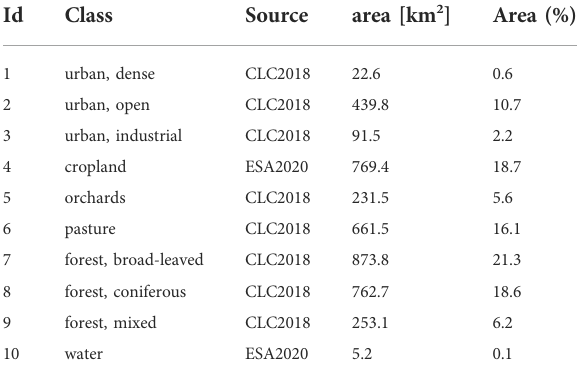
TABLE 2 De fi nition and distribution of land use/land cover reference classes in the study